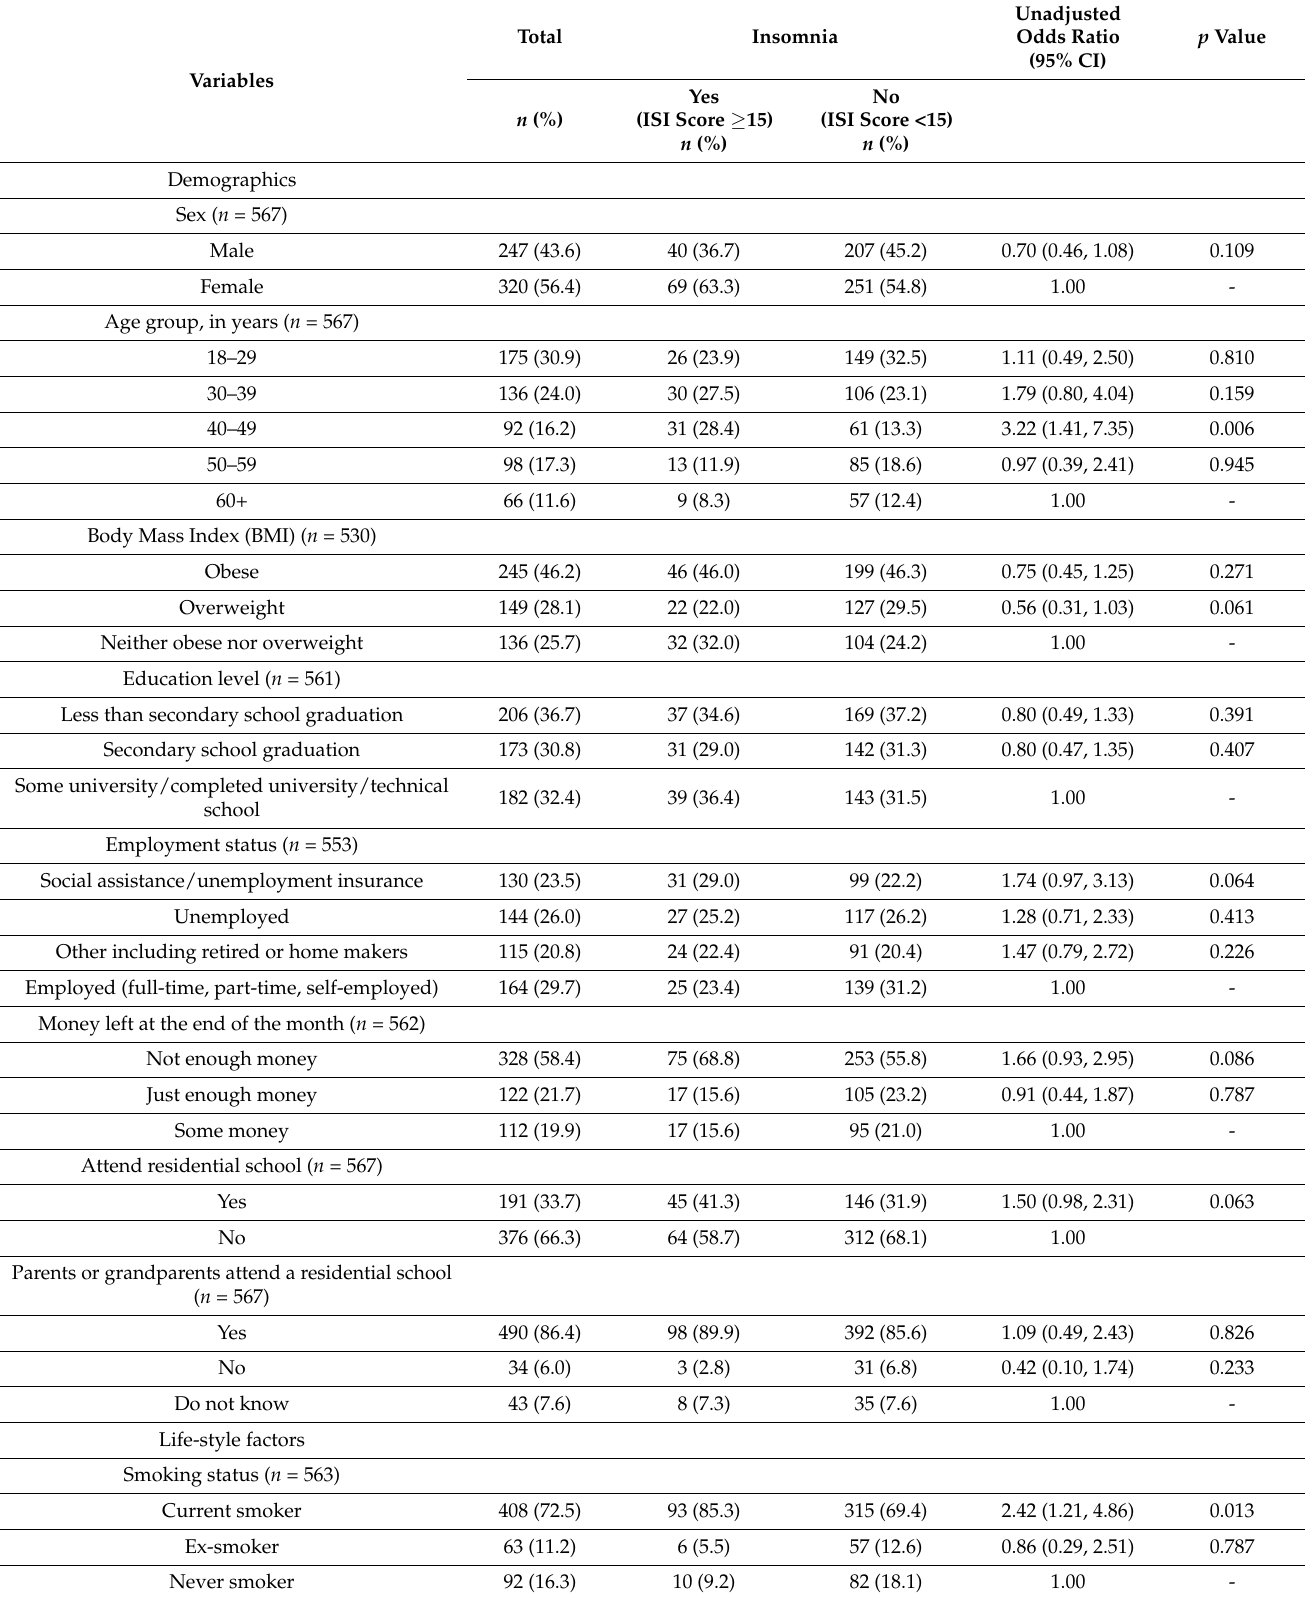
Unadjusted Odds